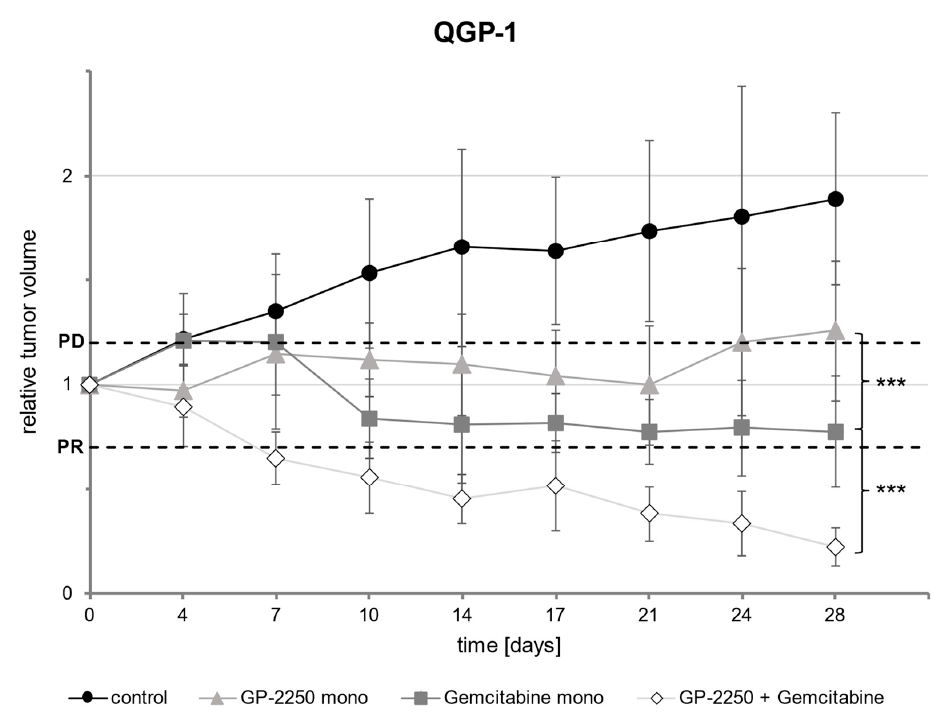
Figure 6. Development of the relative tumor volume of QGP-1 during the observation period. Figure 6 shows the development of the relative tumor volume during the observation period of Bo99 tumors treated with Gemcitabine mono and a combination of Gemcitabine and GP-2250 in comparison to the untreated controls. Error bars show the standard deviation. p -values are indicated as follows: *** p ≤ 0.001.